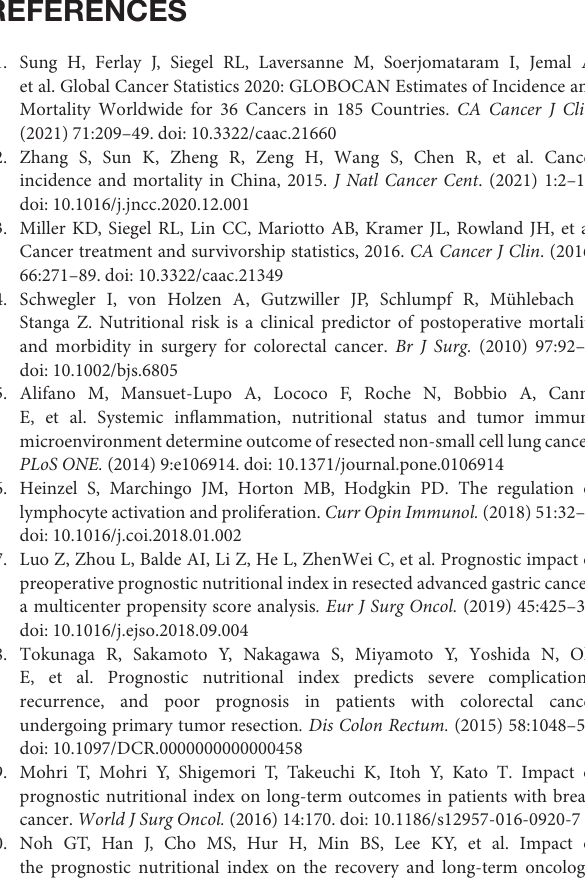
Supplementary Figure S1 | The optimal cutoff value of PNI was determined by optimal stratification method. Supplementary Figure S2 | Box plot of clinicopathological features based on low and high PNI group. The boxplots show the 5 and 95% confidence intervals. The box plot lower extreme is the first quartile and the box plot upper extreme is the third quartile. Box plots show the median and whiskers are the minimum and maximum, respectively. The statistical method used for each group was the student’s t -test. p > 0.05, ∗ p < 0.05, ∗∗ p < 0.01, ∗∗∗ p < 0.001. Supplementary Figure S3 | Postoperative complication rate and hospital stay according to preoperative prognostic nutritional index categories.